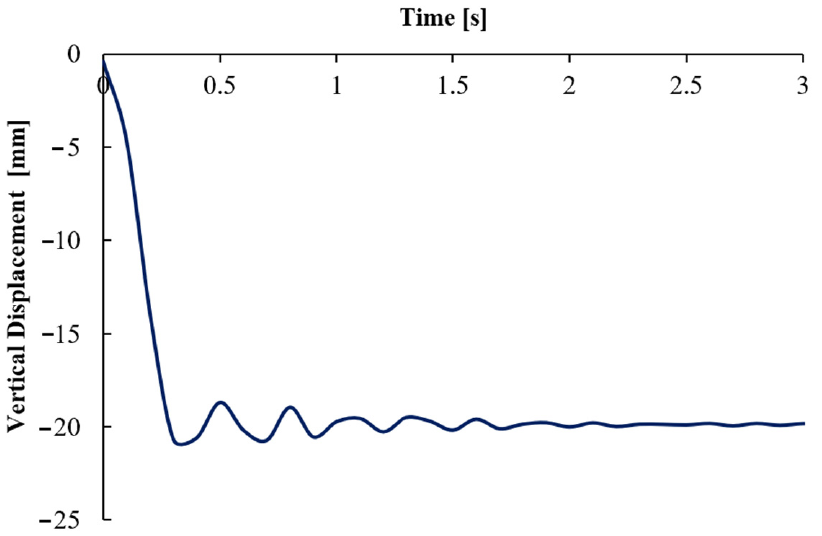
Figure 12: the internal columns (No. 3, No. 4, and No. 5) are characterized by a bigger tributary area under vertical loads and the hypothetical damage to one of them could cause a bigger reduction in the capacity.